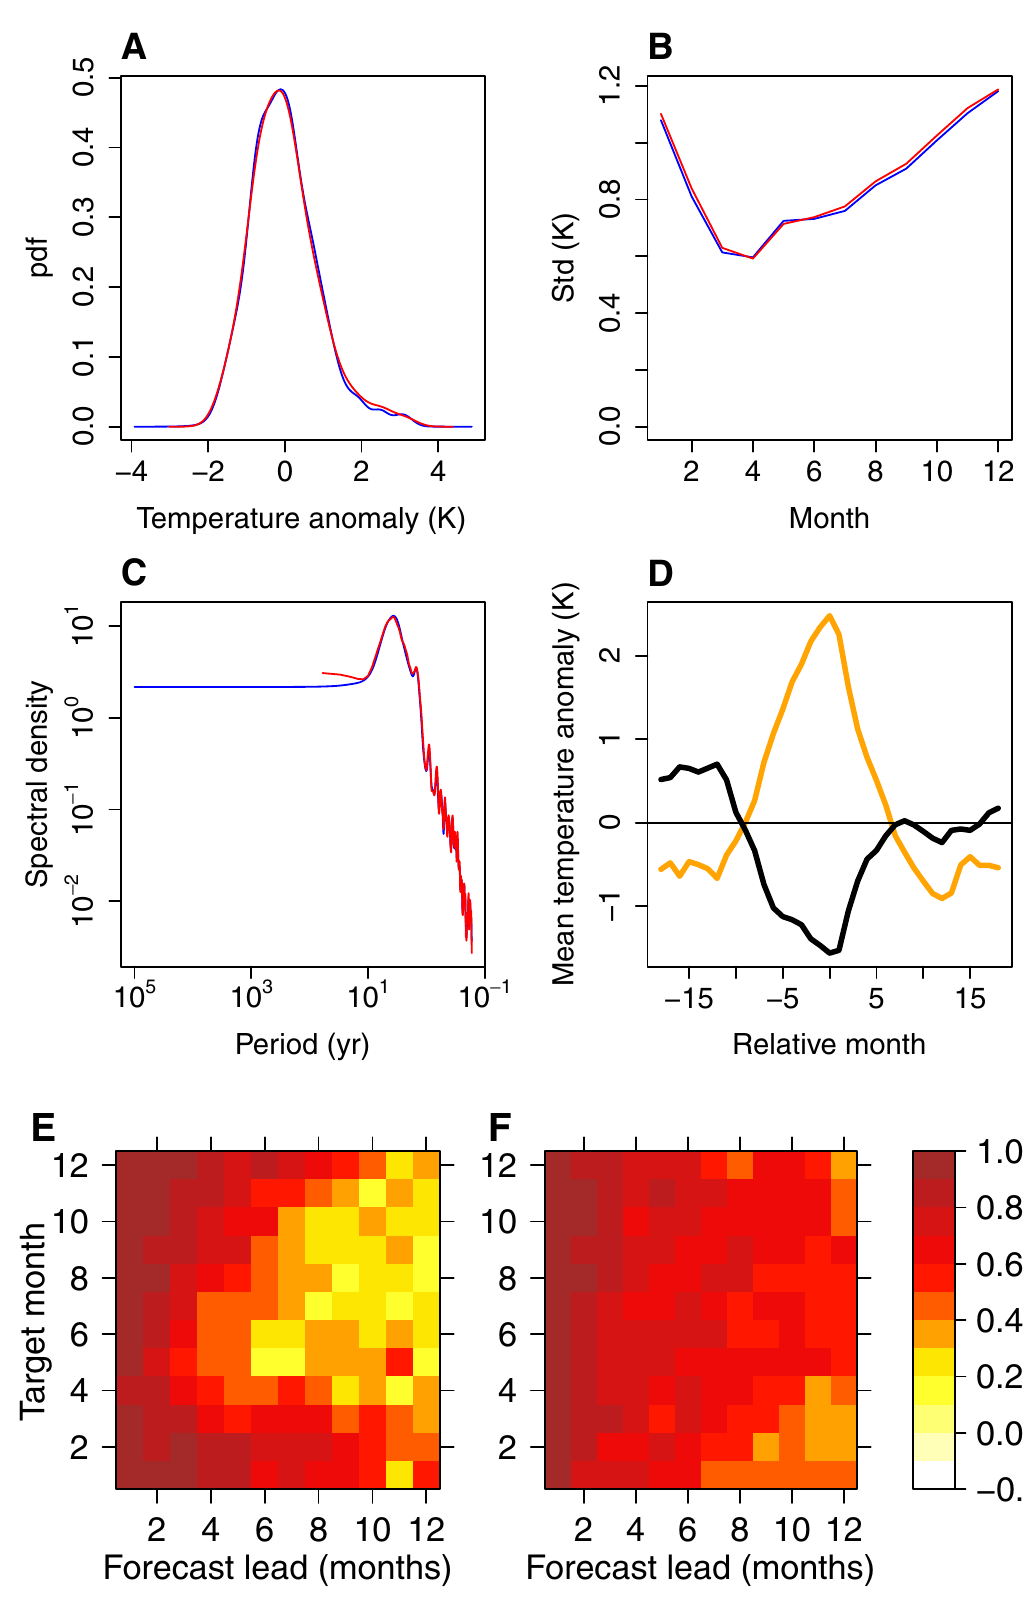
Figure 4. Same as Fig. 3, but for the case of complex time-dependent input forcing that was block-resampled from the